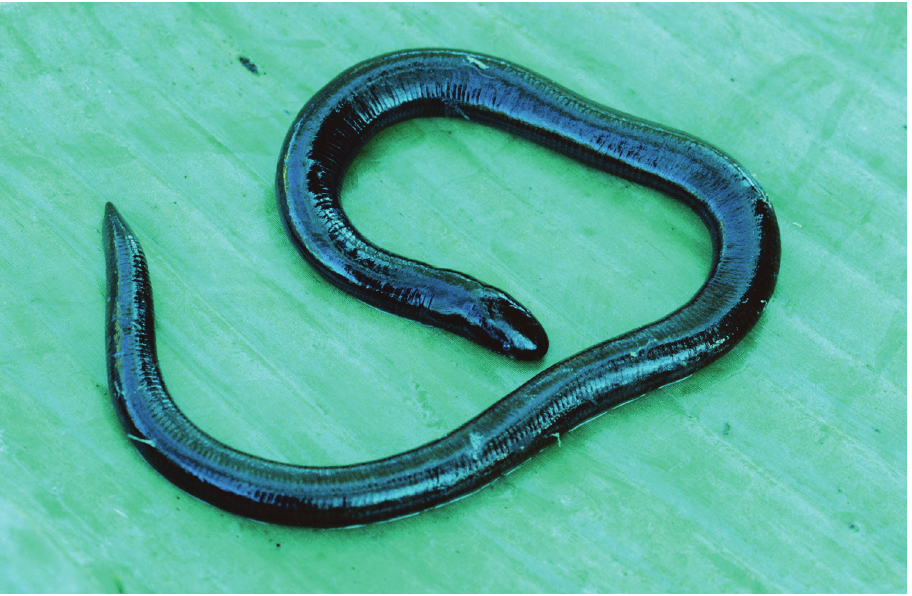
Figure 38. Ichthyophis mindanaoensis has been collected in Mt. Magdiwata, Municipality of San Fran- cisco, Agusan del Sur Province. Photo: RMB (from Davao City Province, specimen deposited in Cincin- nati Museum of Natural